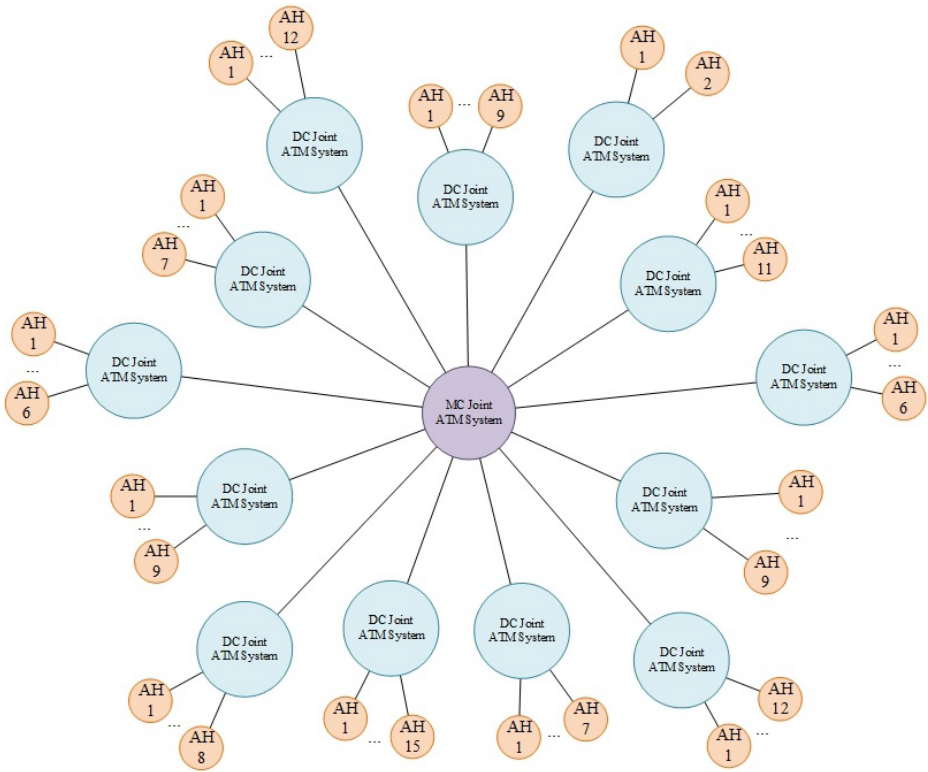
Figure 7. The structure of the operational bodies of the unified ATM system after 15 June